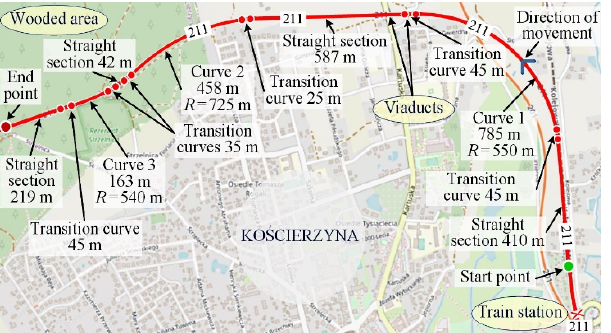
Figure 1. The trajectory of railway line no. 211 from Ko ś cierzyna train station https://www.openrailwaymap.org (accessed on 9 December 2021).